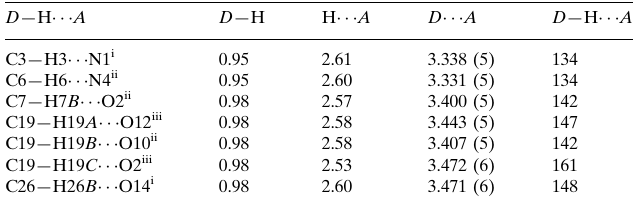
Hydrogen-bond geometry (A˚ , (cid:2)